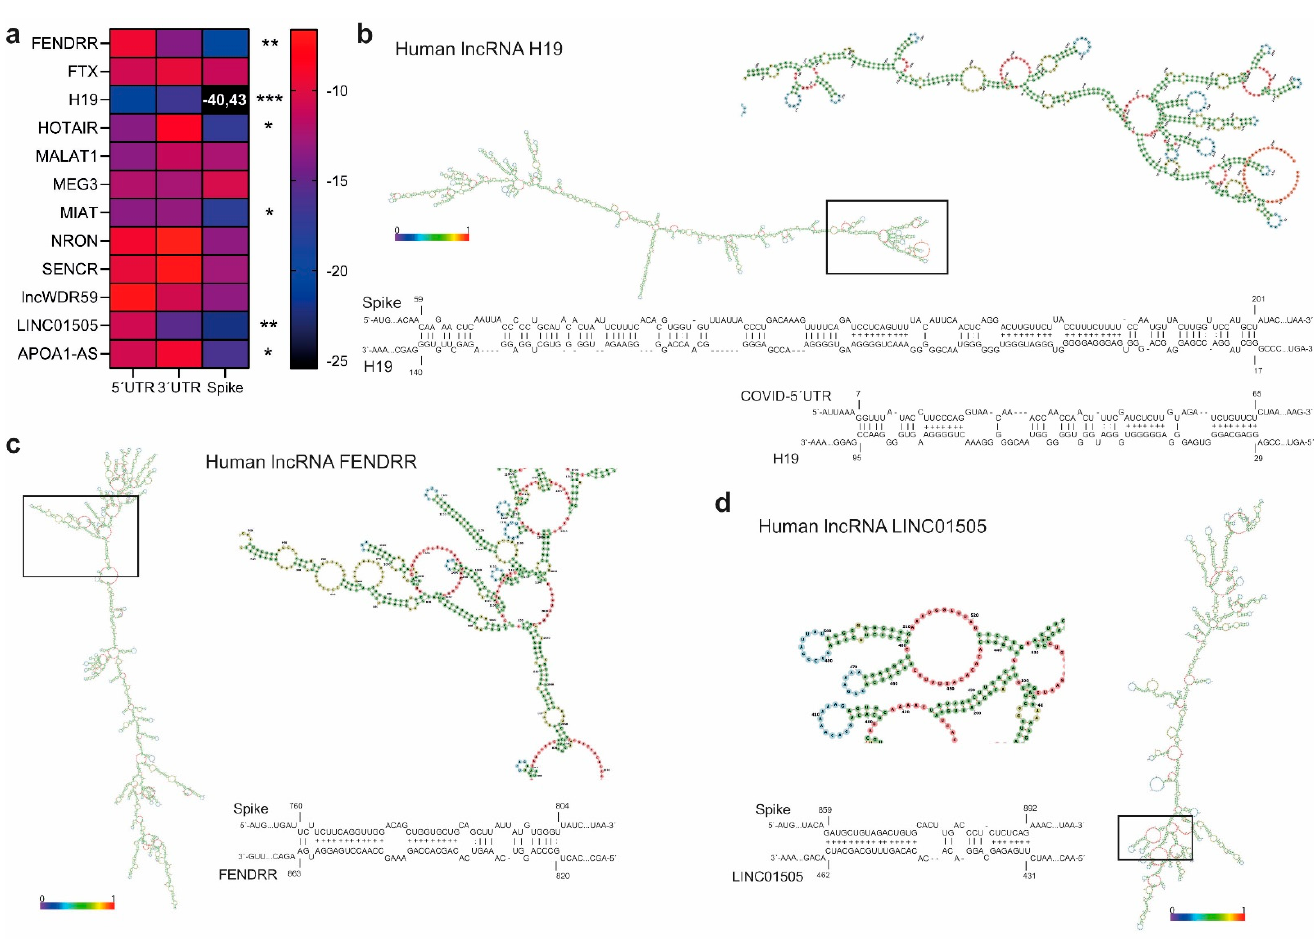
Figure 5. Interaction propensity of lncRNAs involved in pulmonary arterial hypertension, antiviral response, and inflamma- tory diseases. ( a ) Heat map of lncRNA interaction propensity with SARS-CoV-2 5 (cid:48) UTR, 3 (cid:48) UTR, and with Spike mRNA using IntaRNA, RNAup, and RNAplex. Significantly binding sites for Spike were identified for cytoplasmic ( b ) lncRNAs H19 (and for 5 (cid:48) UTR), ( c ) FENDRR, and ( d ) LINC01505. Nuclear lncRNAs were used as negative control. Rectangles represent the zoomed view of lncRNA interaction loops. LncRNA minimum free energy secondary structures were predicted using RNAfold web tool. Colors represent base pair probabilities. * p < 0.05; ** p < 0.01; *** p <